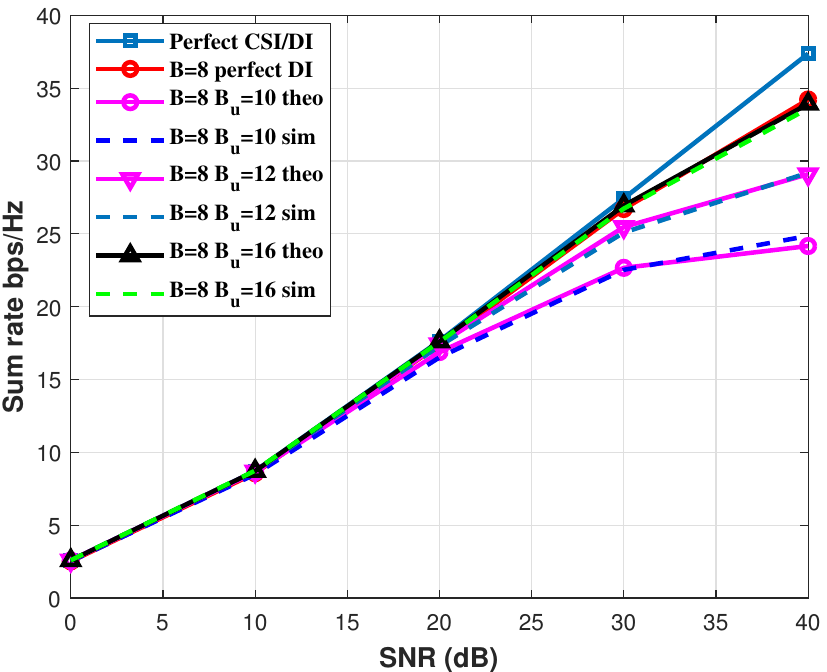
Figure 11. Performance comparison of theoretical and simulation results with SQ-based CSI feedback and RVQ-based DI feedback with different quantization bits in ( 2 × 2,1 ) 3.